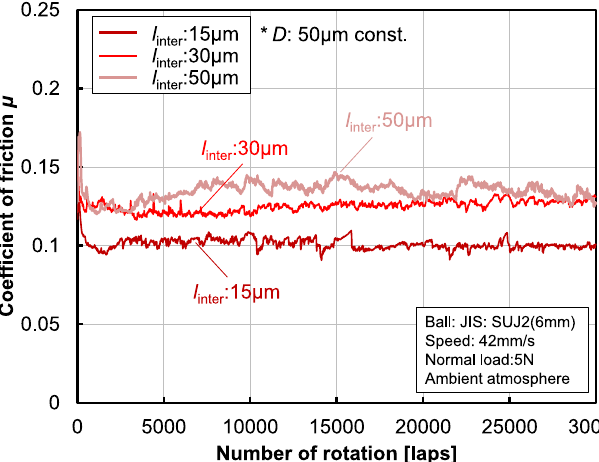
Fig. 8. Evolution of COF during ball-on-disk friction test of micro-textured DLC fi lms with different texture interspace under constant texture diameter of 50